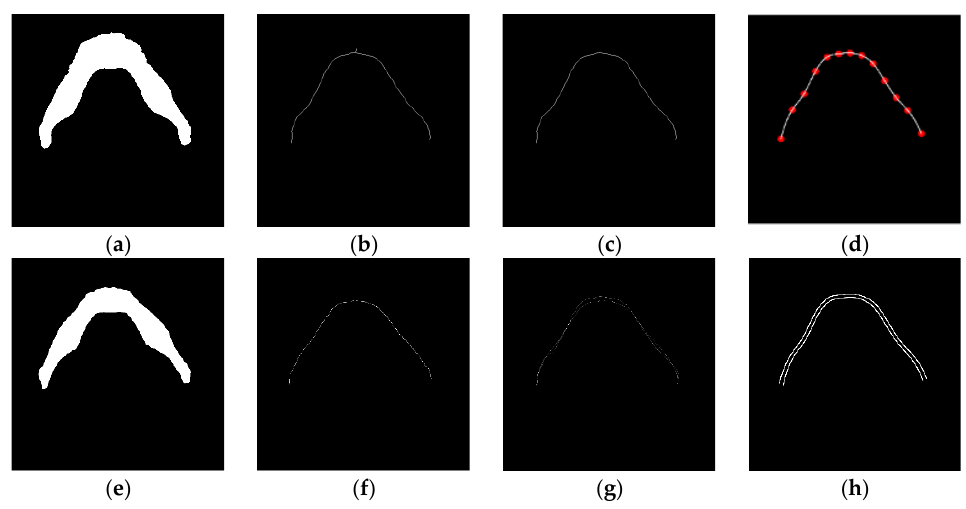
Figure 4. Extraction and transformation process of the dental arch curve. ( a ) Contour image after expansion corrosion. ( b ) The skeleton line after thinning. ( c ) Skeleton line after de-bifurcation. ( d ) The dental arch line is fitted by cubic spline curve. ( e ) The skeleton line of coronal MIP of mandible after de-bifurcation. ( f ) The skeleton line of coronal MIP after decapitation. ( g ) Calculation of the curve distance image in ( e , f ) . ( h ) The dental arch curve after equidistant transformation.